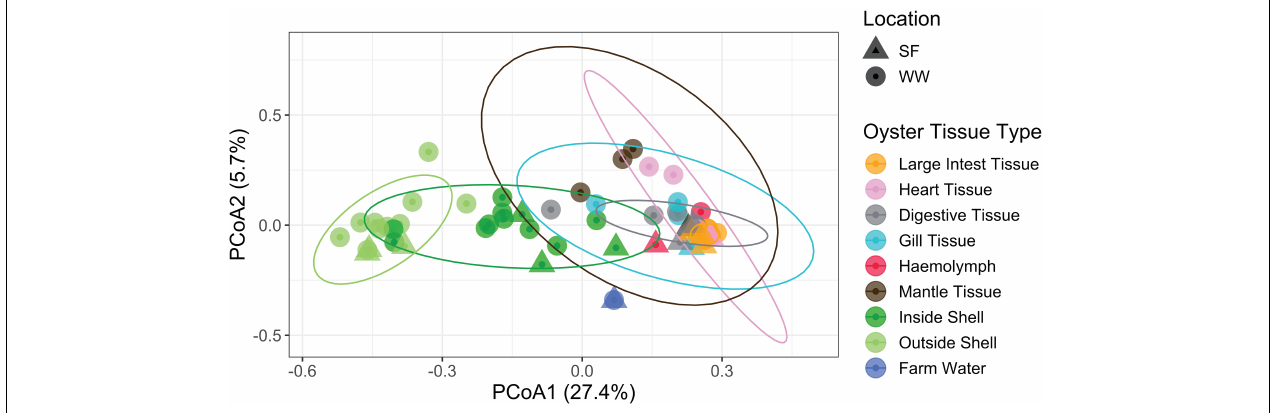
FIGURE 2 | PCoA ordination of bacterial compositions labeled by location and oyster tissue type. The first axis explained 27.4% of the microbiota variance and the second 5.7%. Ellipses show 95% data distribution.